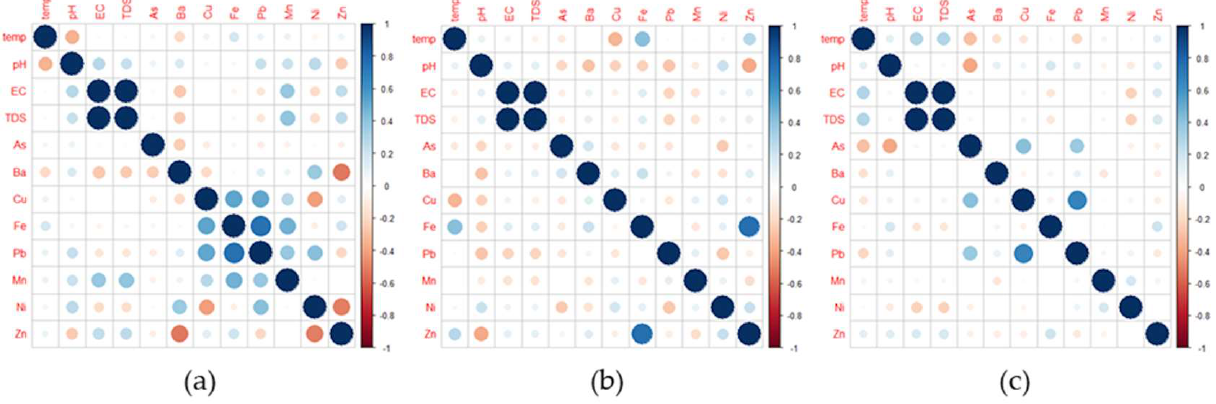
Figure 12. Correlation matrix plots of WQ parameters obtained for ( a ) TW samples, ( b ) GW samples,